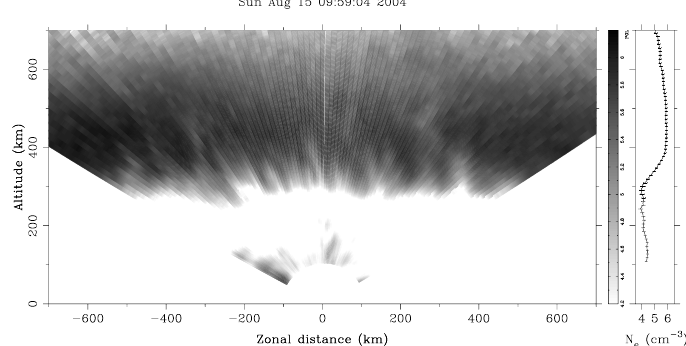
Fig. 16. Altair radar oblique scan for 15 August 2004, 09:59